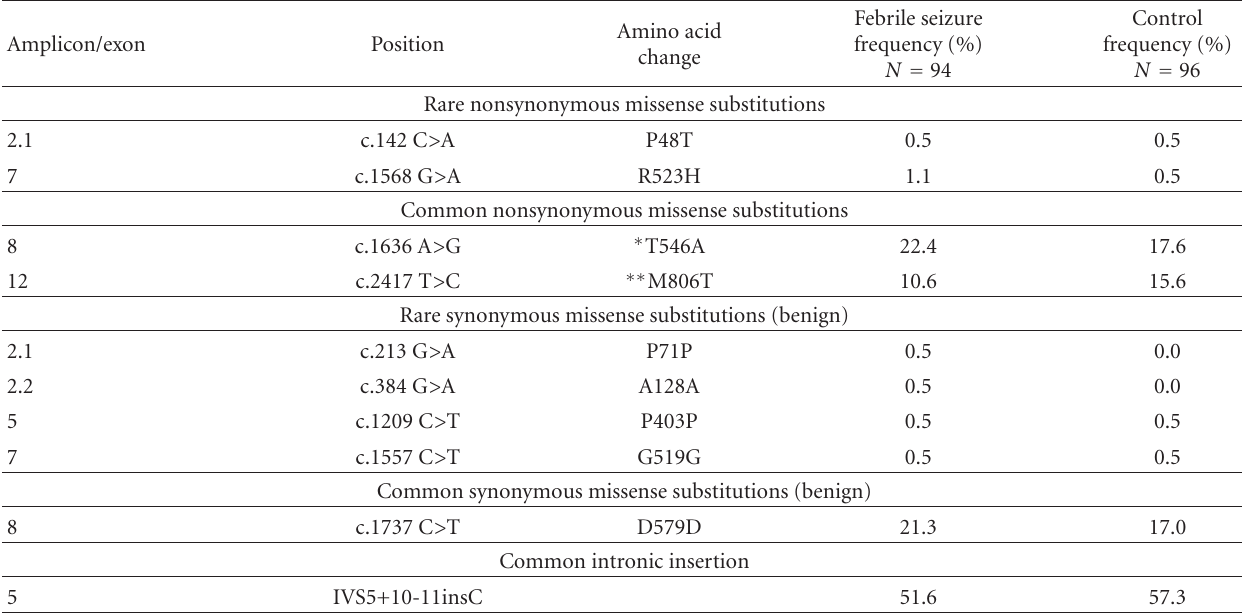
Table 2: Genetic variation detected within SEZ6